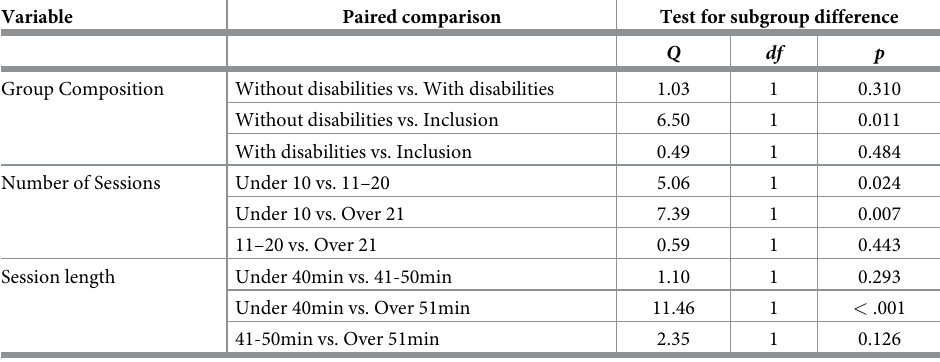
Table 5. Post-hoc effect size